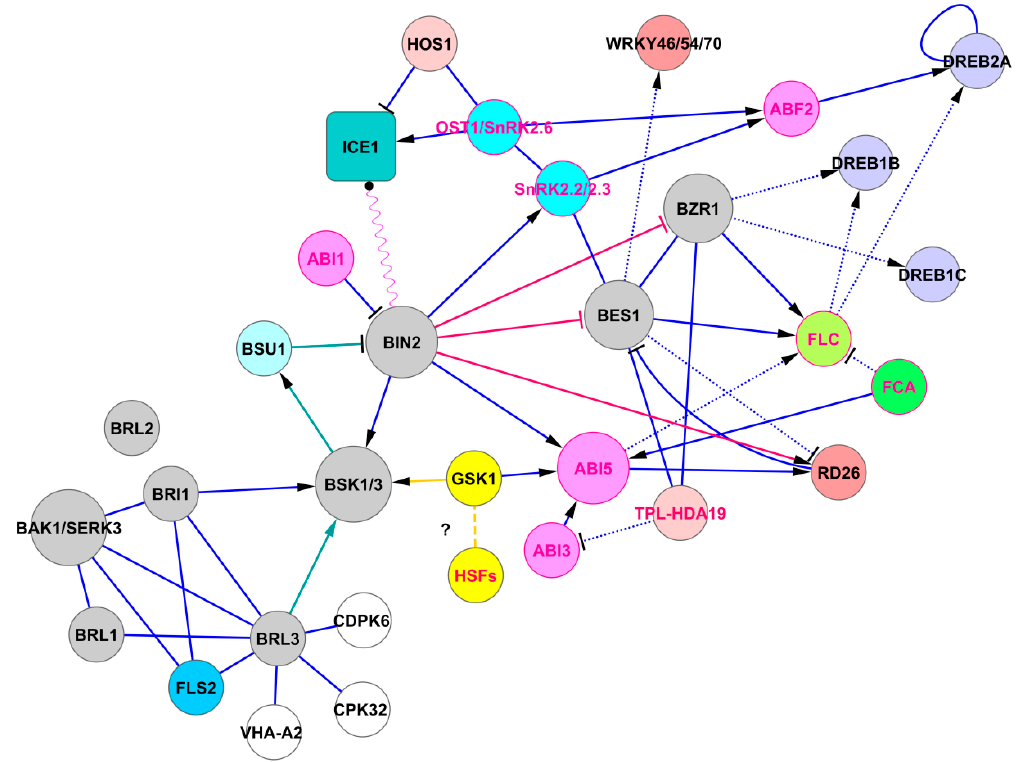
Figure 1. The pathway of BRL3 signaling. Brassinosteroid receptors BRL1, BRL3, and BRI1 / BAK1 trigger the BR signaling pathway (proteins of the BR signaling system are shown in gray). BRL2 is not connected to this system. Solid lines represent protein–protein interactions presented in PAIR, IntAct, and BioGRID, and dashed lines represent possible interactions taken from STRING. Dotted lines represent transcriptional regulation. Green lines indicate signaling in the module BRL3 → BSK1 / 3 → BSU1 — (cid:107) BIN2. BIN2 regulates expression of BZR1 and BES1. BIN2 regulates drought tolerance directly by activating RD26, indirectly via BZR1-DREB1B and SnRK2.2 / 2.3-ABF2-DREB2A pathways. BIN2 also interacts with ICE1, implementing time-dependent regulation of the SnRK2.6 / OST1-HOS1-ICE1 cold signaling module. Finally, BIN2 activates ABI5, an important concentrator of ABA signals. Red protein labels indicate that these proteins are involved in stress memory generation. These interactions were visualized using the program Cytoscape as described previously [27]. The data loaded into the program were obtained from PAIR version 3.3 [http: // www.cls.zju.edu.cn / pair / ]. The